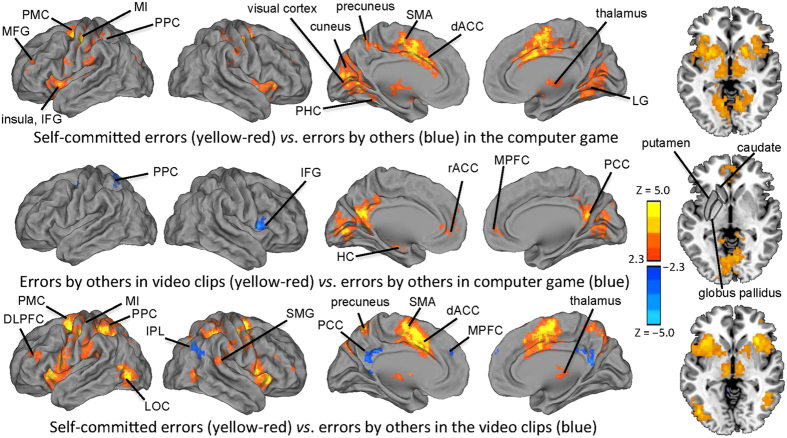
Brain regions wherein there were significant differences in hemodynamic activity between the conditions in Experiment 1 are indicated here with color maps overlaid on reconstructed cerebral hemispheres and on axial slice at z = −2 mm that cuts through the striatal structures.(TOP) The red-yellow color scale indicates brain regions that exhibited significantly larger hemodynamic responses following self-committed errors in the computer game than following watching of errors committed by another player. We failed to see any brain areas with significantly larger hemodynamic responses to errors committed by others in the game play as compared with responses to self-committed errors. (MIDDLE) The red-yellow color scale indicates brain regions that exhibited significantly larger hemodynamic responses following errors by others in the short video clips than following watching of errors committed by another player in the record of computer game play. The blue color indicates brain regions that exhibited significantly larger activity following observation of errors in the computer game play than following observation of the errors contained in the short video clips. (BOTTOM) The red-yellow color marks brain areas that exhibited significantly larger hemodynamic responses following self-committed errors in the computer game than following watching of errors committed by others in the short video clips. The blue color indicates brain regions that exhibited significantly larger activity following observation of errors by others in the video clips than following self-committed errors in the game play. All statistical parameteric maps were thresholded Z > 2.3 and cluster-wise corrected at P < 0.05.